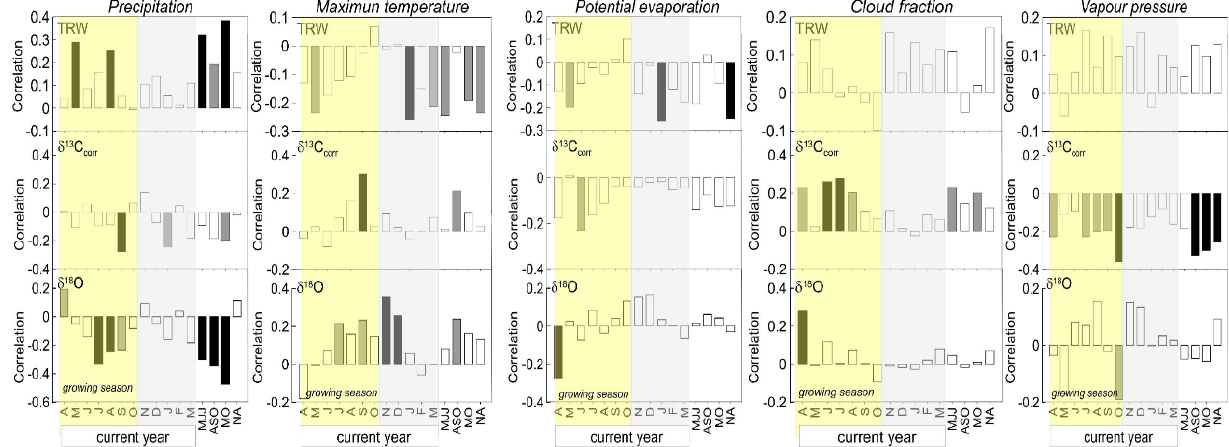
Figure 6. Correlation between the tree-ring chronology (TRW) ( top panel ), tree-ring δ 13 C chronology ( middle ) and tree-ring δ 18 O chronology ( lower panel ) with CRU TS4.04 climate data (precipitation, maximum temperature, potential evaporation, cloud fraction, and vapor pressure). The black bars indicate significance at p < 0.01 , the gray bars are significant at p < 0.05 , and the white bar graph indicates non-significant correlation values. The yellow frame indicates the growing